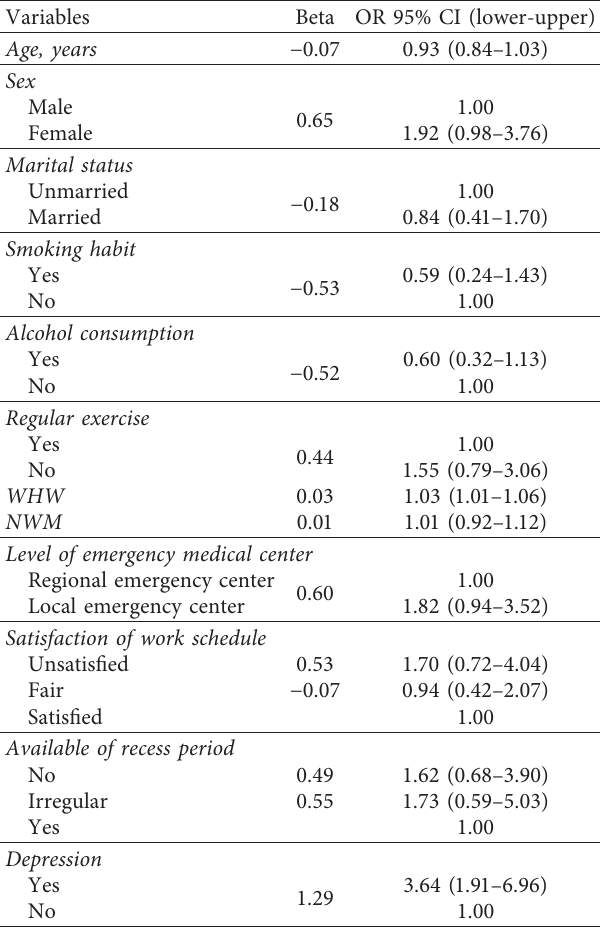
Table 3: Analysis of associated factors of EDS in EM residents.